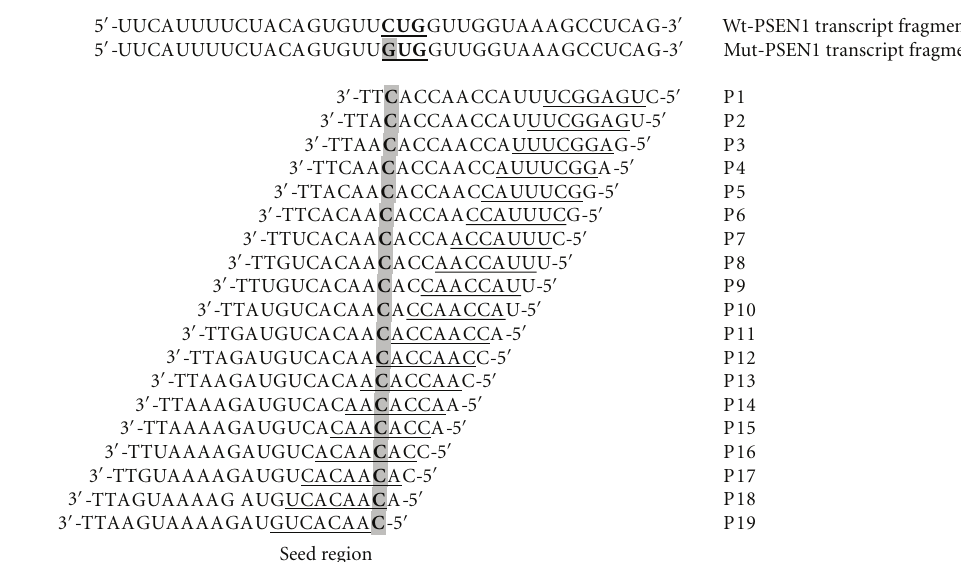
level of A β 42 released from control fibroblasts (CELMA Aβ 42